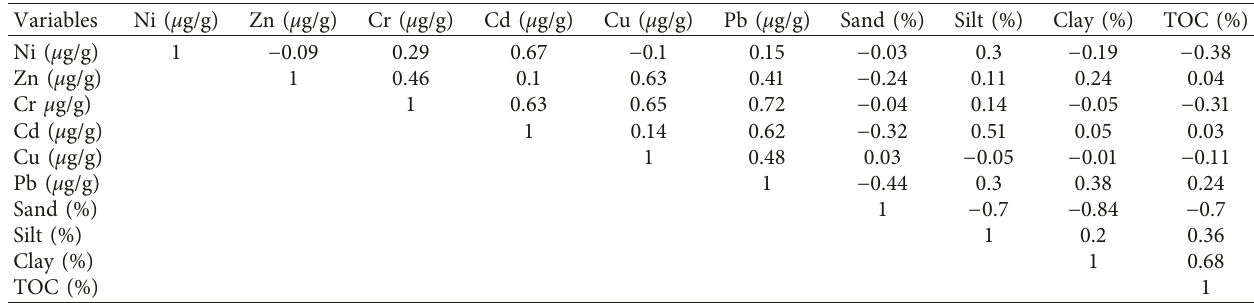
Table 7: Pearson coefficient for Ni, Zn, Cr, Cd, Cu, Pb, sand, clay, silt, and TOC for surface sediments of the Rades-Hamam Lif coast.